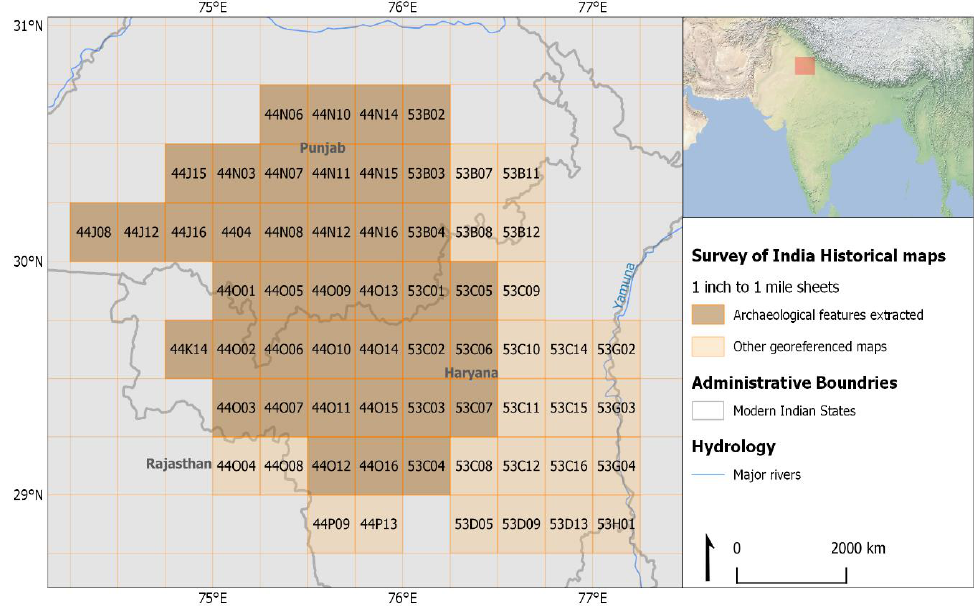
Figure 7. Geographical location of the georeferenced Survey of India 1” to 1-mile map sheets used in this study.